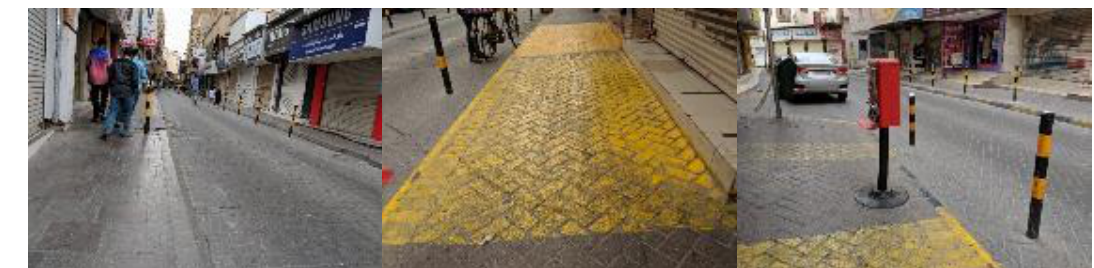
Figure 13. Street furniture: in term of Miss-use Billboards i.